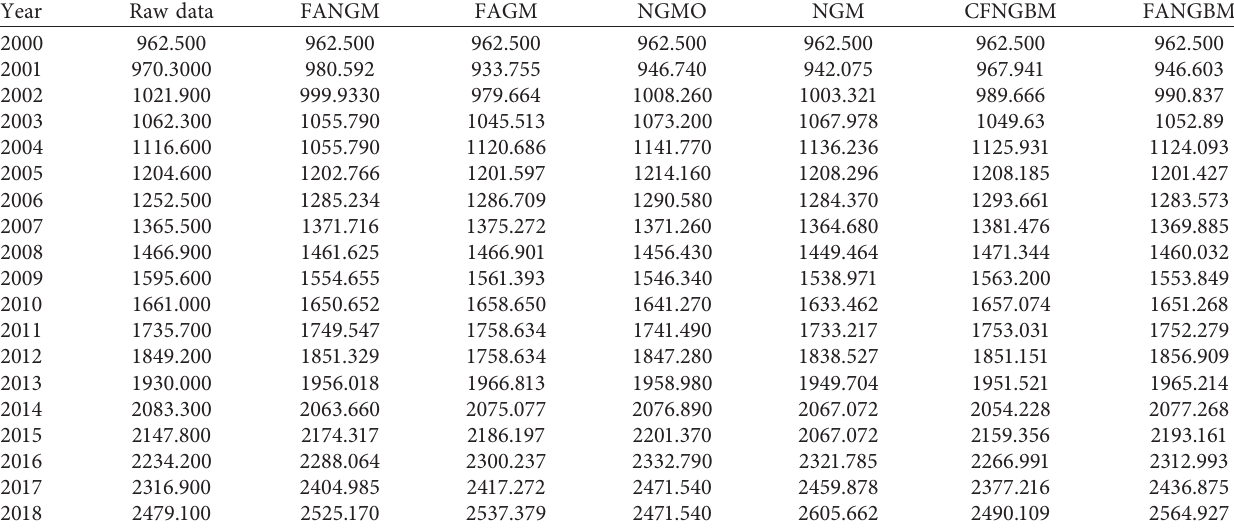
Table 8: Results of CO 2 emissions in India using six